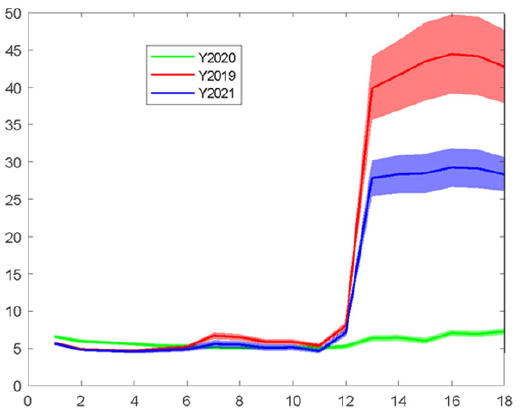
Figure 6. Differences of MSI spectra with respect to the year of harvest.